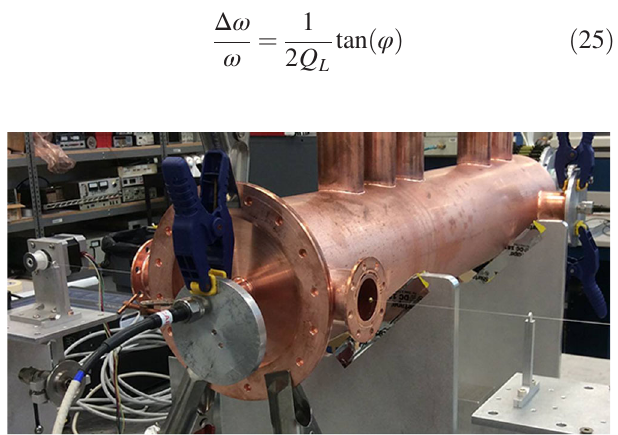
FIG. 17. Complete bead pull measurement